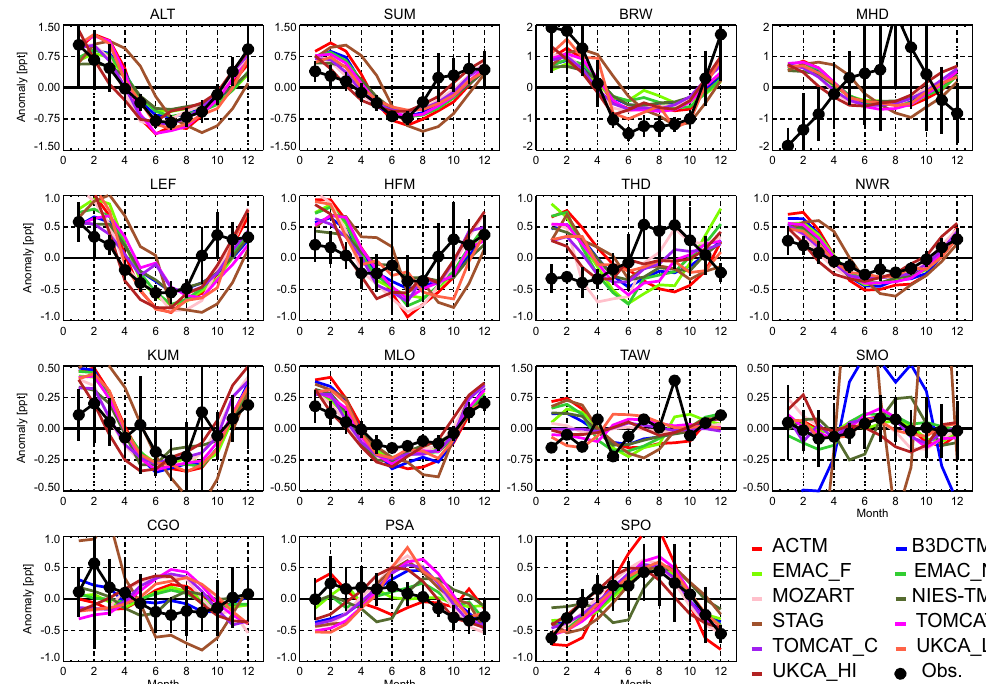
Figure 3. Comparison of the observed and simulated seasonal cycle of surface CHBr 3 at ground-based measurement sites (see Table 3). The seasonal cycle is shown here as climatological (1998–2011) monthly mean anomalies, calculated by subtracting the climatological monthly mean CHBr 3 mole fraction (ppt) from the climatological annual mean, in both the observed (black points) and model (coloured lines; see legend) data sets. The location of the surface sites is summarised in Table 3. Model output based on CHBr 3 _L tracer (i.e. using aseasonal emissions inventory of Liang et al., 2010). Horizontal bars denote ± 1 σ .